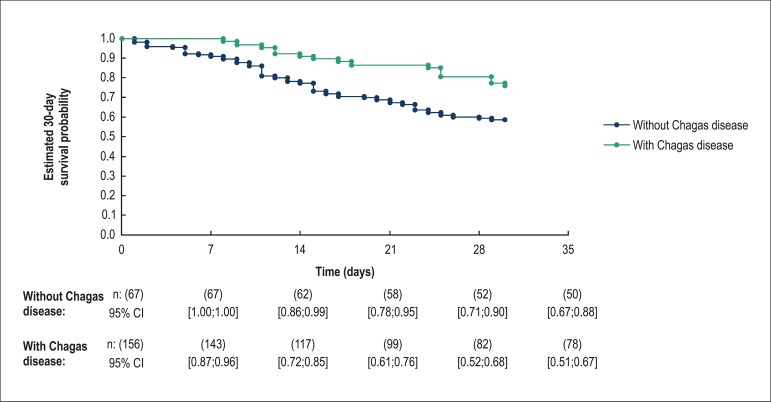
Comparison of 30-day mortality between patients with Chagas disease and
other cardiomyopathies. n: number of patients at risk; 95% CI: 95%
confidence interval. p value was calculated using the Log-rank test: p
= 0.008.